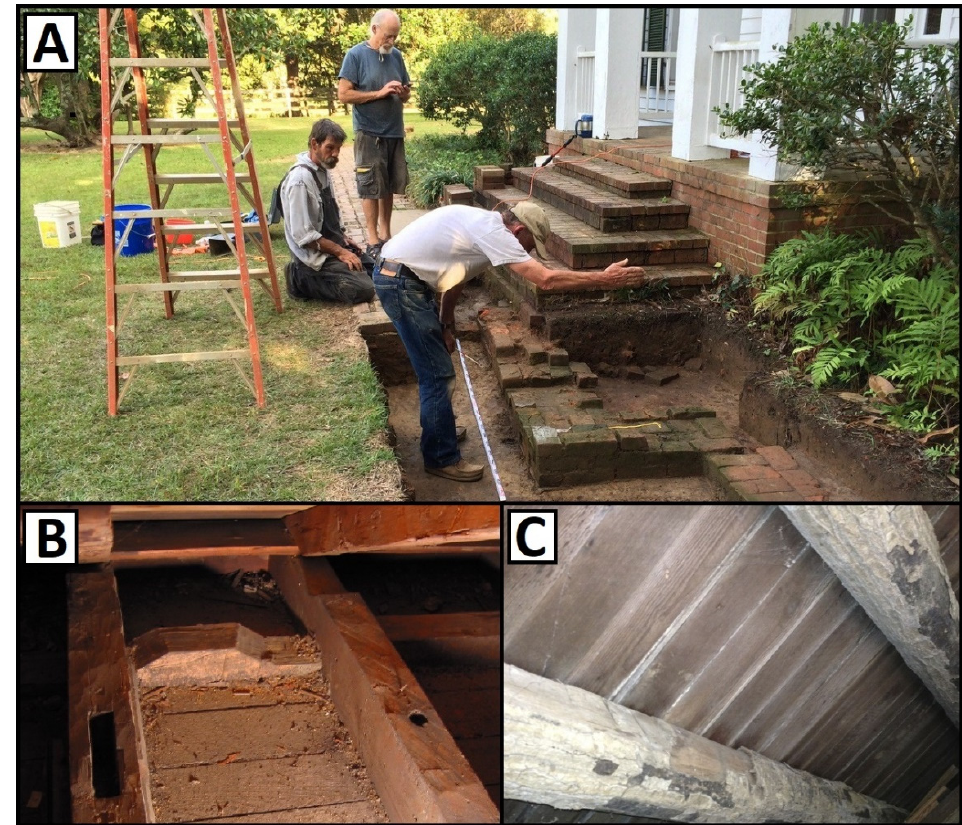
Figure 1. Walker House ( A ) pre-existing brick foundation, ( B ) hand-finished attic timbers, and ( C ) crawlspace oak joists. Photos by R. Doherty.